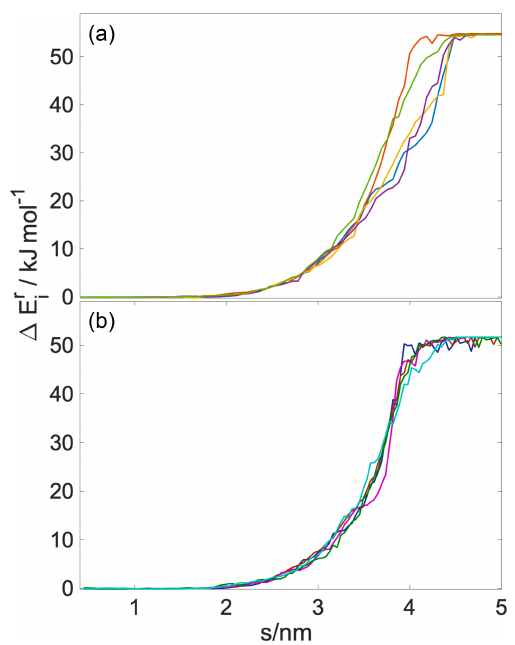
Figure B1. Internal energy profiles of selected realizations: (a) 200 and (b) 300K.